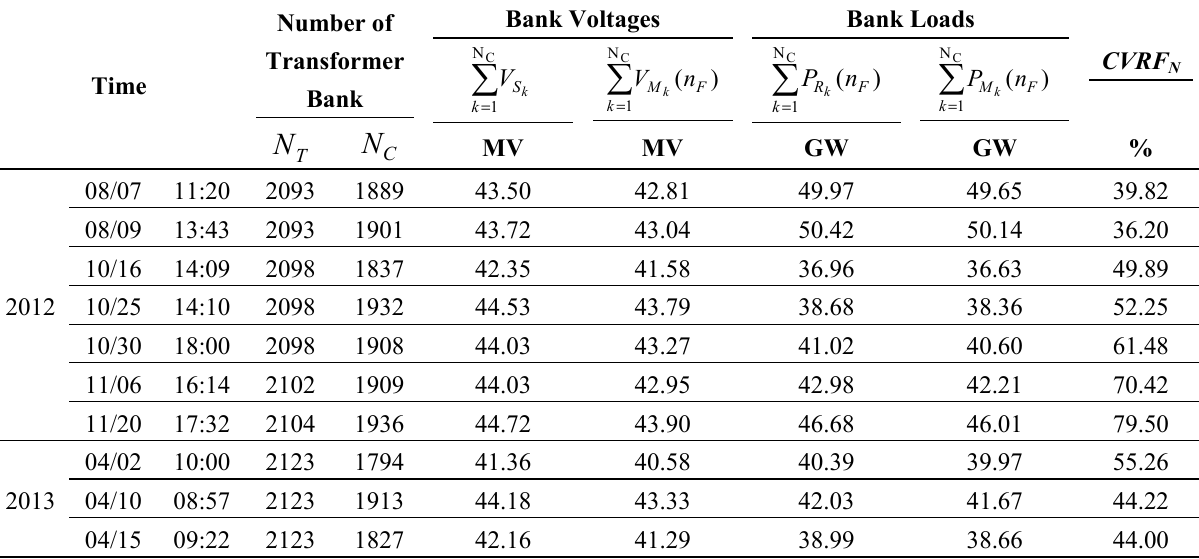
Table 1. National CVR factors of the Korean power